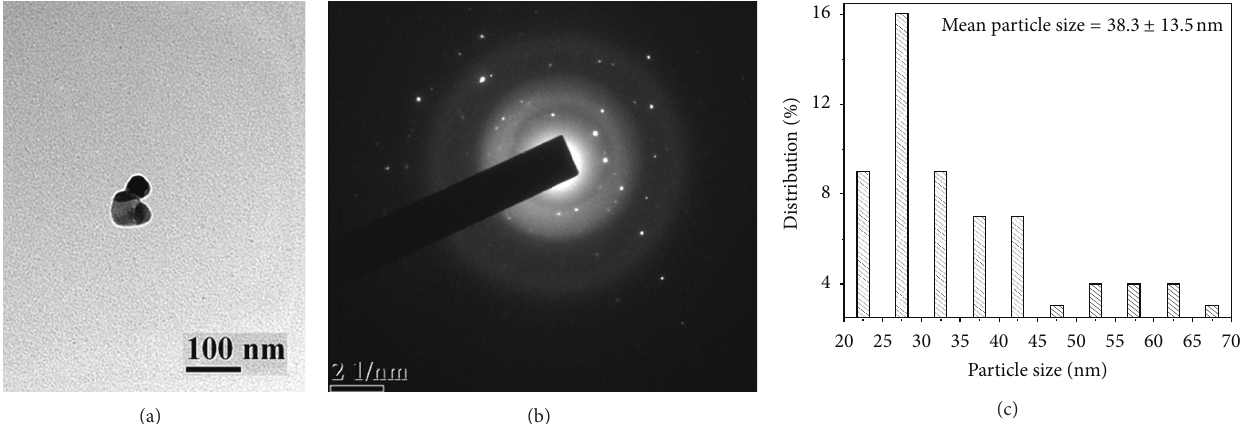
Figure2:TEMimagesofcitratestabilizedsilvernanoparticle,at(a)100 nmscale,(b)correspondingSAEDpattern,and(c)histogramshowing the particle size distribution.